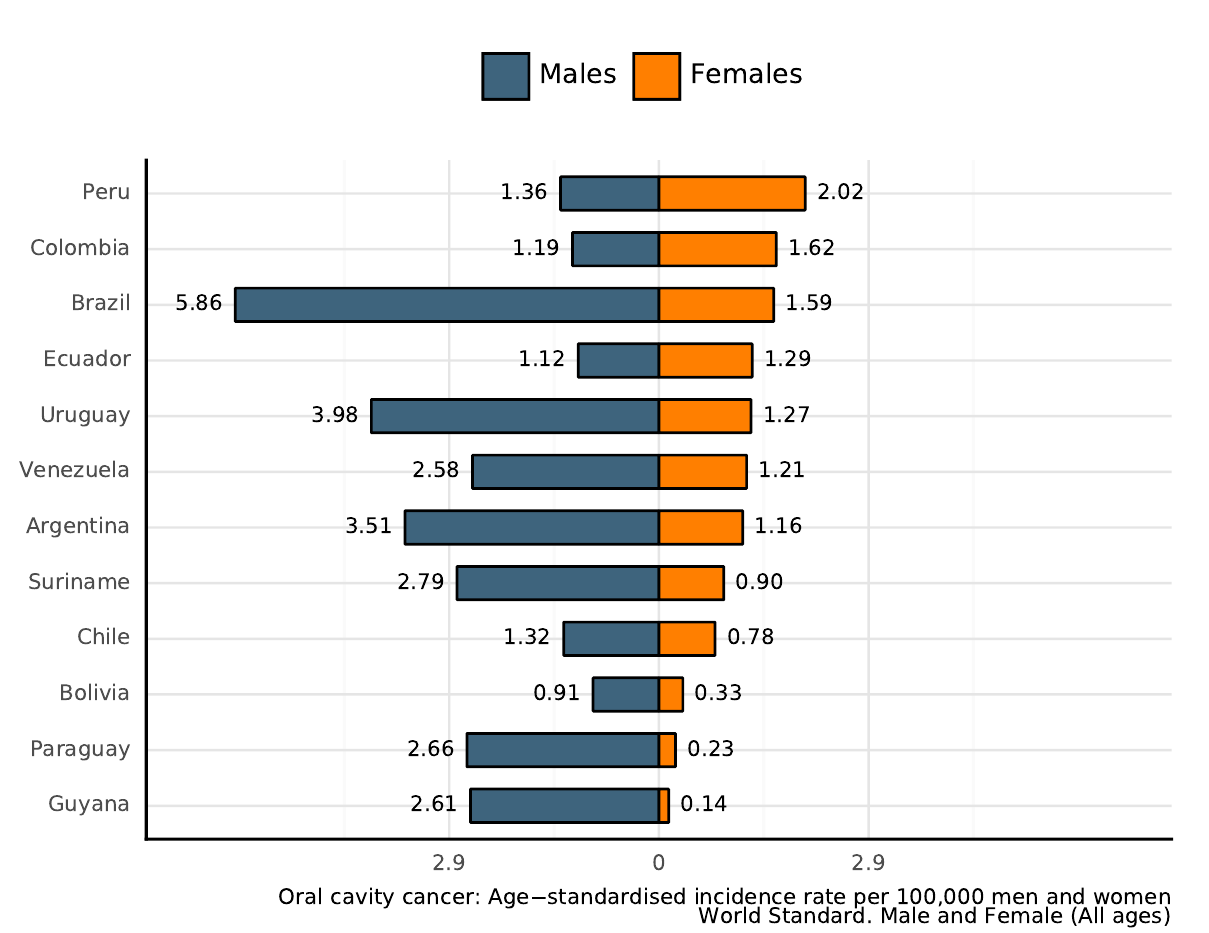
Oral cavity cancer: Age standardised incidence rate per 100,000 men and women World Standard. Male and Female (All